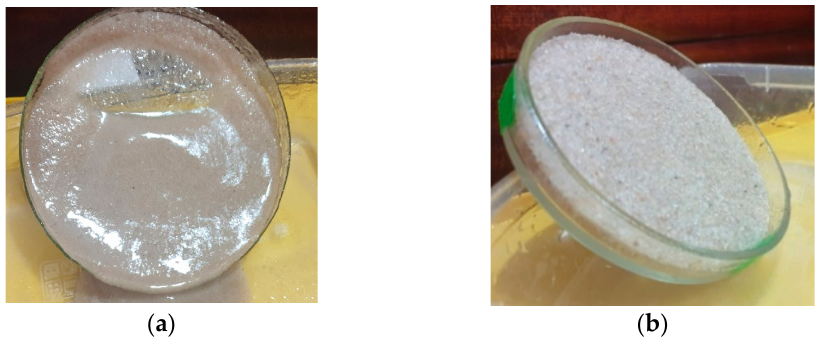
Figure 6. A Petri dish with moistened sand treated by PDADMAC ( a ) and BSM–PDADMAC formulation with W = 0.2 ( b ).